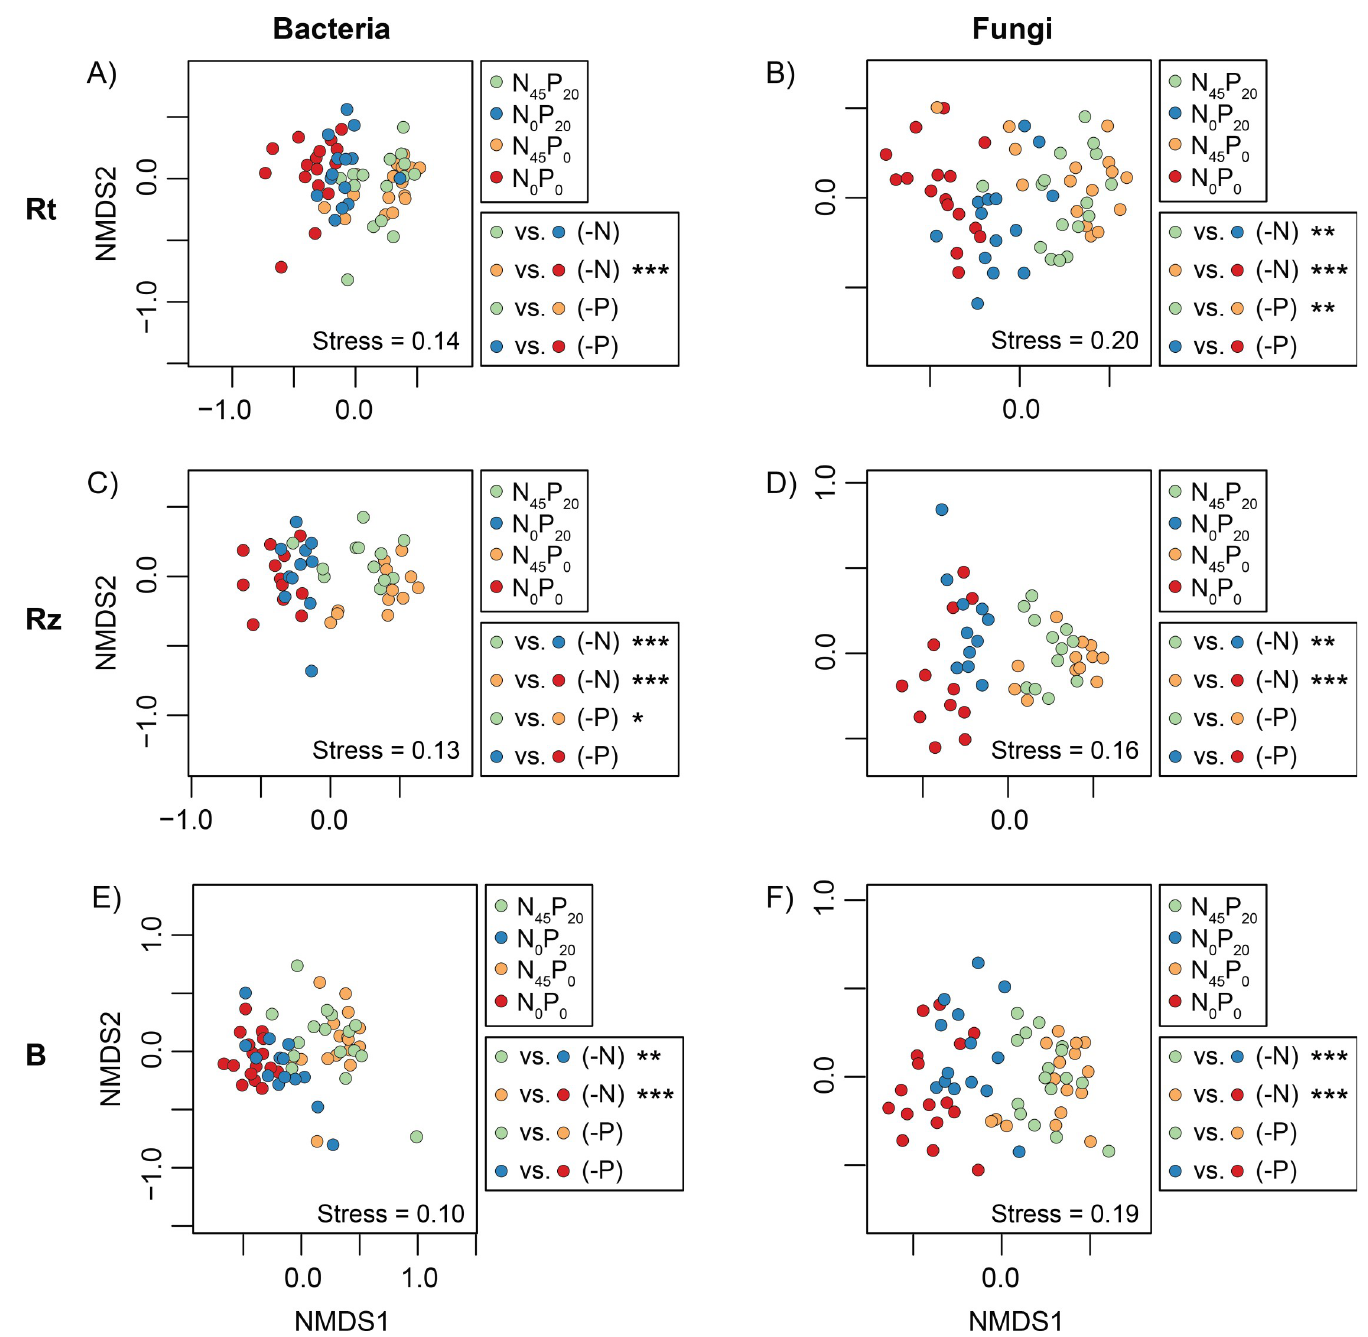
Fig 2. Microbial community comparisons—fertilization. Non-metric multidimensional scaling (NMDS) ordinations representing the dissimilarity (Bray-Curtis) of microbial communities sampled in the different Rotation A plots. The significance of pairwise comparisons is reported next to each graph ( � = p < 0.05; �� = p < 0.01, ��� = p <